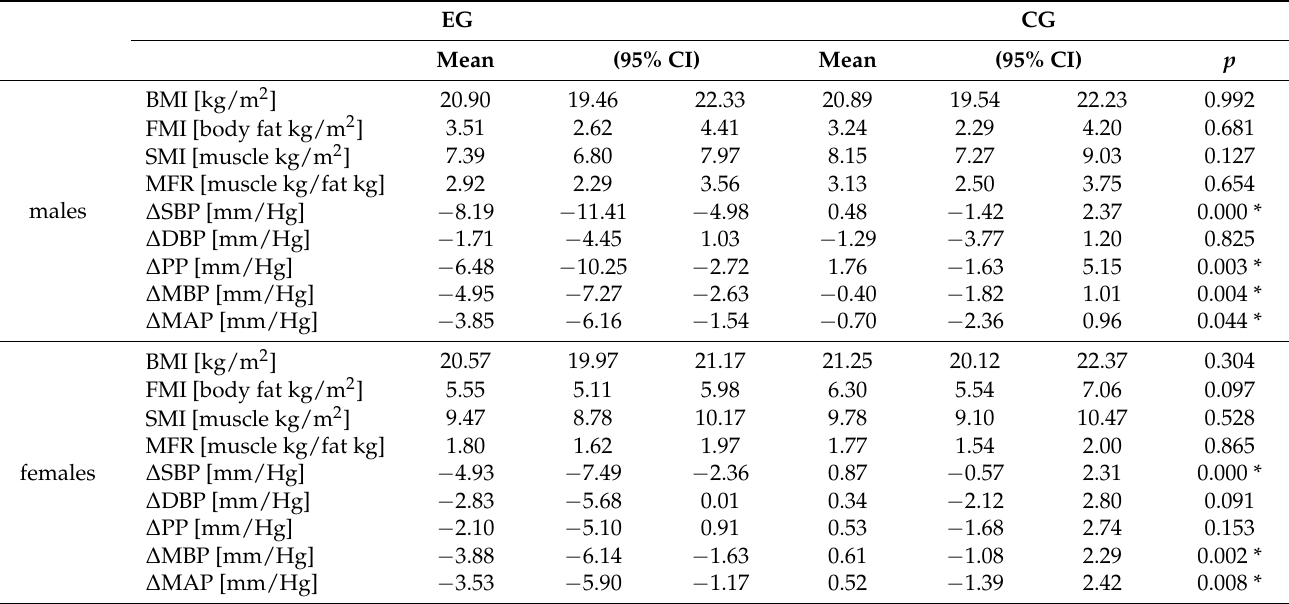
Table 1. Descriptive statistics and p -values derived from t -Student tests for differences between EG and CG (in males’ and females’